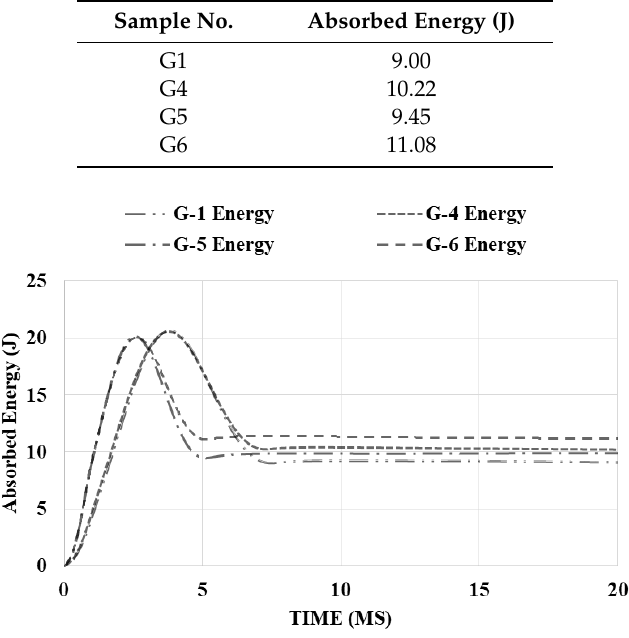
Table 4. Measured absorbed energies for glass-fiber plates.